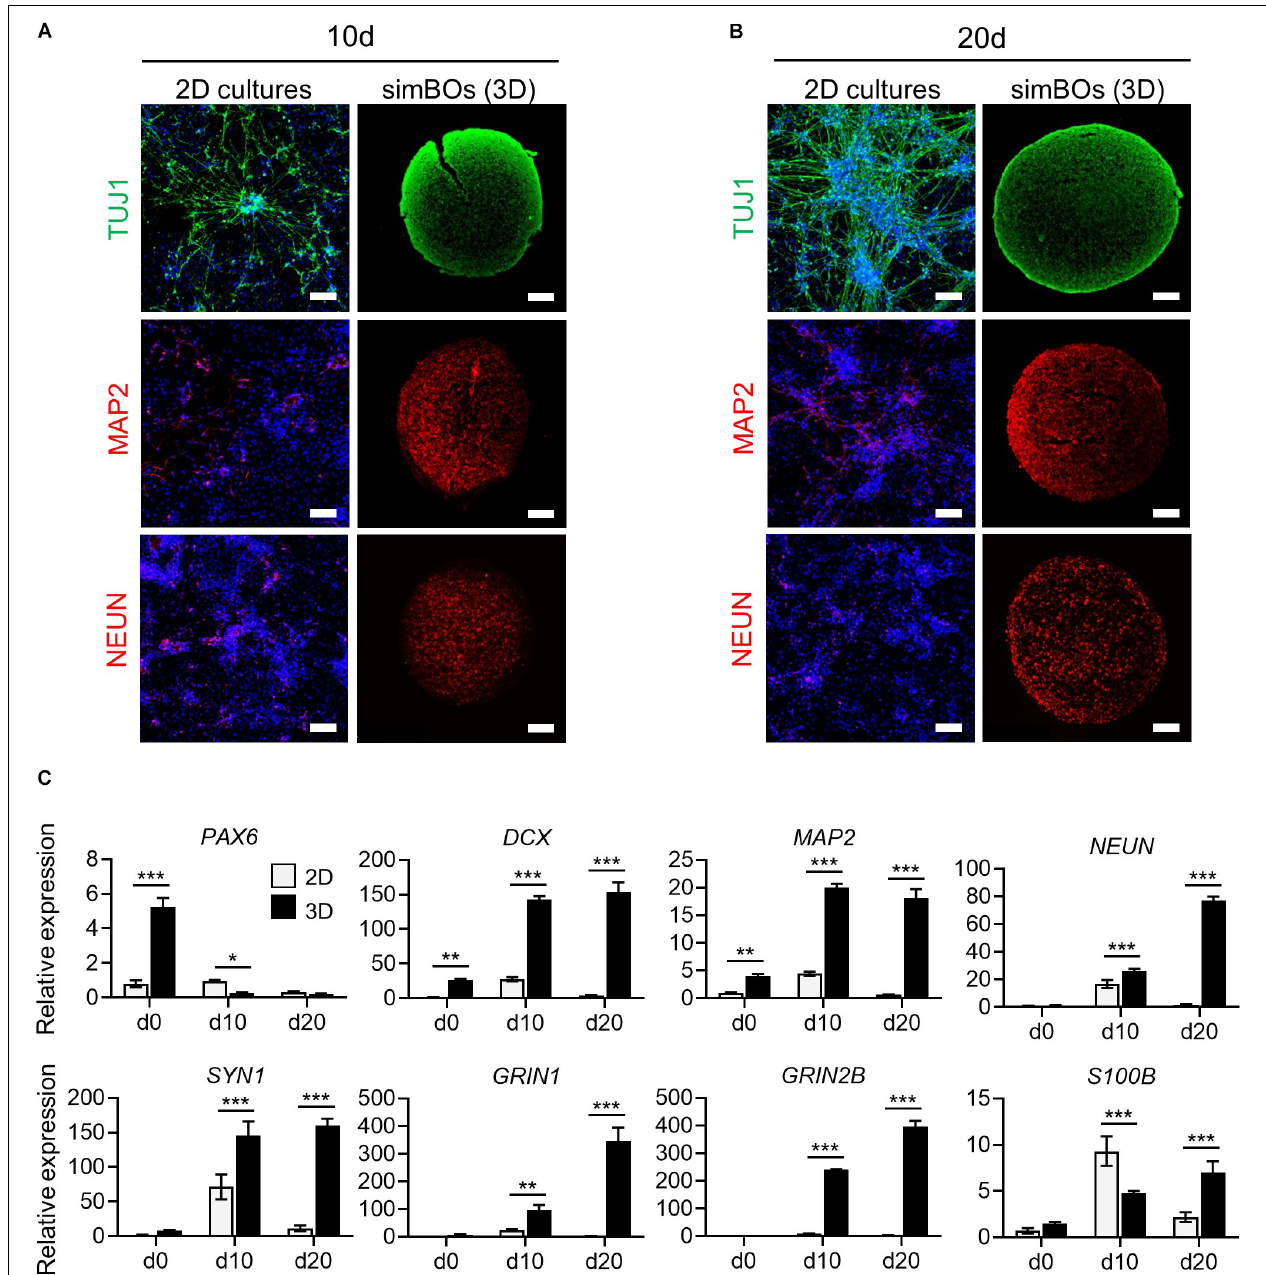
FIGURE 3 | Comparison of neuronal differentiation potential in 2D vs. 3D. (A,B) Immunofluorescence analysis to compare neuronal differentiation potential between 2D and 3D with neuronal markers (TUJ1, MAP2, and, NEUN) in simBOs at day 10 (A) and 20 (B) of spontaneous differentiation. Scale bars represent 100 µ m. (C) Quantitative reverse transcription polymerase chain reaction (qRT-PCR) analysis for neural progenitor marker ( PAX6 ), pan-neuronal markers ( DCX , MAP2 , NEUN , and SYN1 ), glutamatergic neuronal marker ( GRIN1 ), GABAergic neuronal marker ( GRIN2B ) and glial marker ( S100B ) in simplified brain organoids (simBOs; 3D) and 2D differentiation samples. Expression value was normalized to those of human primitive neural stem cells (pNSC) in 2D (d0). Data represent mean ± standard error (SE) from three technical replicates. Statistical significance of Sidak’s multiple comparisons * p < 0.05, ** p < 0.01, *** p < 0.001 after two-way ANOVA.